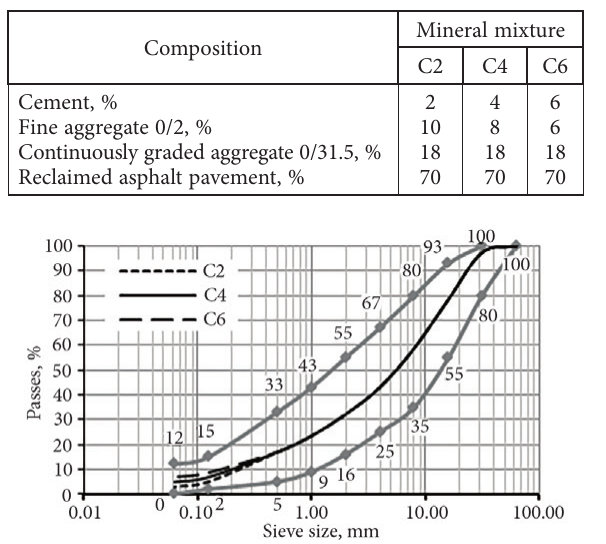
Figure 1. Grading curve of mineral mixtures Table 2. Designations of Mineral-Cement-Emulsion mixtures used in the study and the combination of binding agents Content,